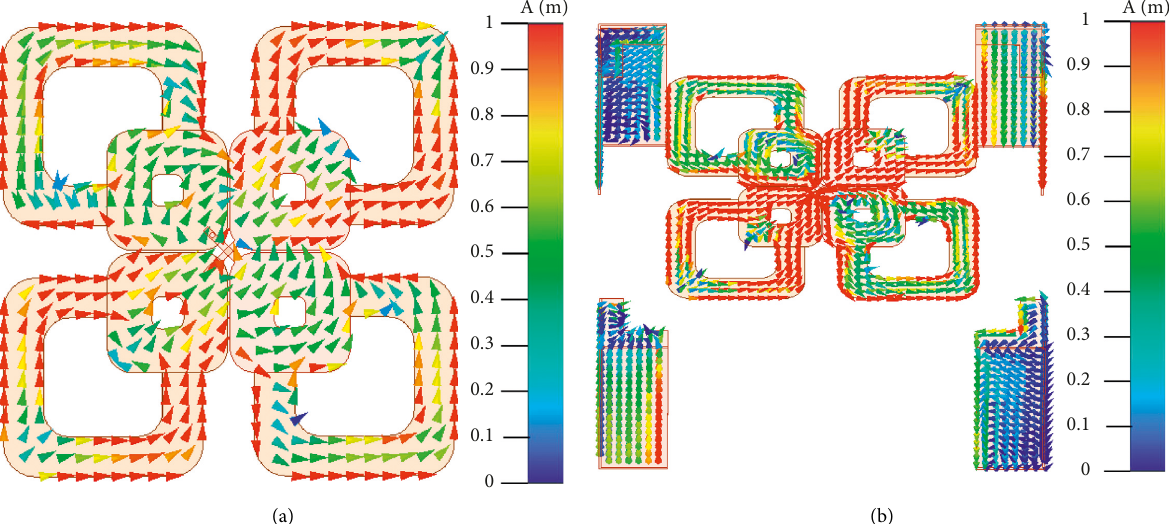
Figure 4: Current distribution. (a) Antenna 1. (b) Antenna